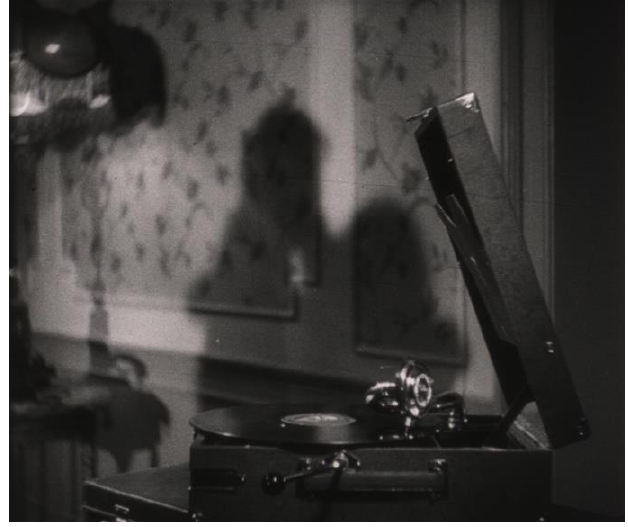
Figure 2. In Silhouetten Reisch uses a gramophone as a diegetic source of music to accompany dramatic scenes (film still, Filmarchiv Austria).